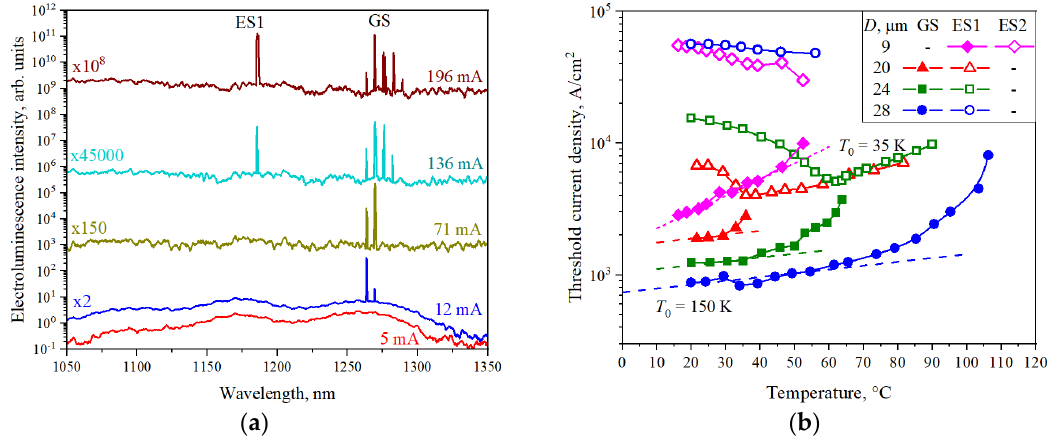
Figure 2. ( a ) Electroluminescence spectra of the microlaser with disk diameter of 24 μ m measured at the different injection currents at room temperature; ( b ) Temperature evolution of the threshold current densities of the first lasing (solid symbols) and two-state lasing (open symbols) for GS, ES1 and ES2 optical transitions in microdisks of different diameters (28 μ m: circles, 24 μ m: squares, 20 μ m: triangles, 9 μ m: rhombs). Dashed curves correspond to the characteristic temperature of 150 K and dotted lines correspond to 35 K.